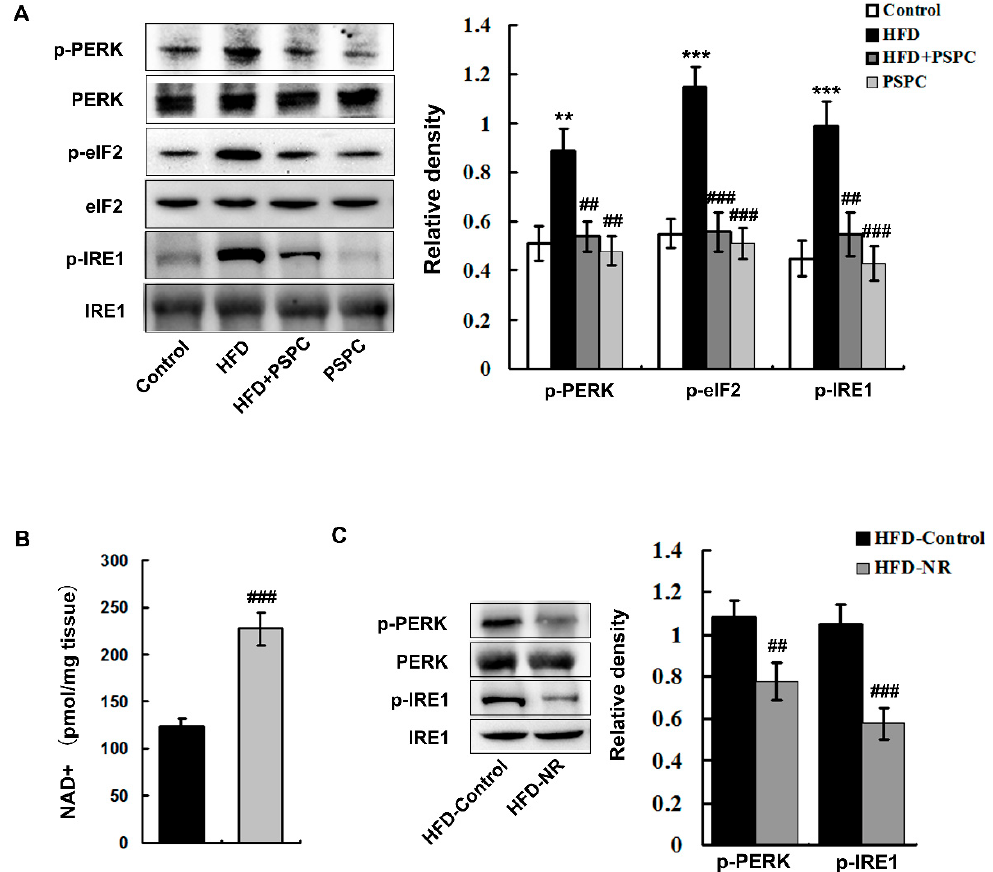
Figure 4. PSPC depresses NAD + depletion-mediated ER stress in HFD-treated mouse livers. ( A ) Immunoblotting and densitometry analysis of ER stress markers in mouse livers ( n = 3); ( B ) Hepatic NAD + levels in all treated groups ( n = 5); ( C ) Immunoblotting and densitometry analysis of ER stress-relative proteins in mouse livers ( n = 3). All of the values are expressed as the mean ± SD. ** p < 0.01, *** p < 0.001 vs. the control group; ## p < 0.01, ### p < 0.001 vs. the HFD group.